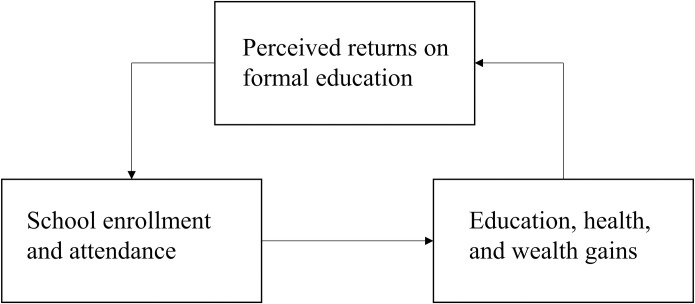
Conceptual framework underpinning the study.Notes: Authors’ conceptual framework where the perceived benefits of secondary school may impact school enrollment and attendance and in turn the measured education (e.g., increased educational attainment), health (e.g., improved sexual and reproductive health outcomes), and household financial gains (e.g., increased employment opportunities, higher salary, and economic independence). The perceived benefits of formal education may also impact schooling during different periods across the life course (e.g., as child and parent) and for different stakeholders (e.g., children’s household and family members).